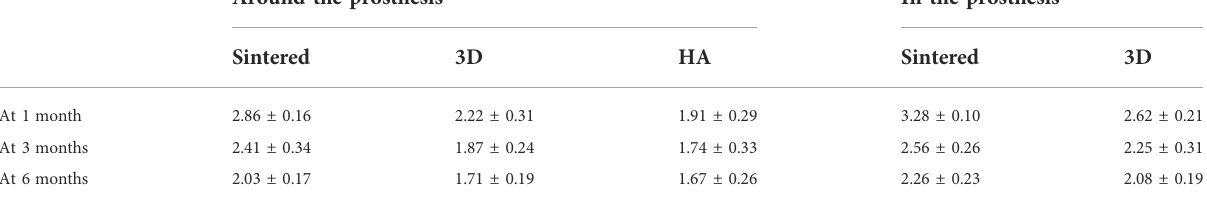
TABLE 2 MAR values of different materials around and inside the acetabular cup prosthesis ( μ m). Around the prosthesis In the